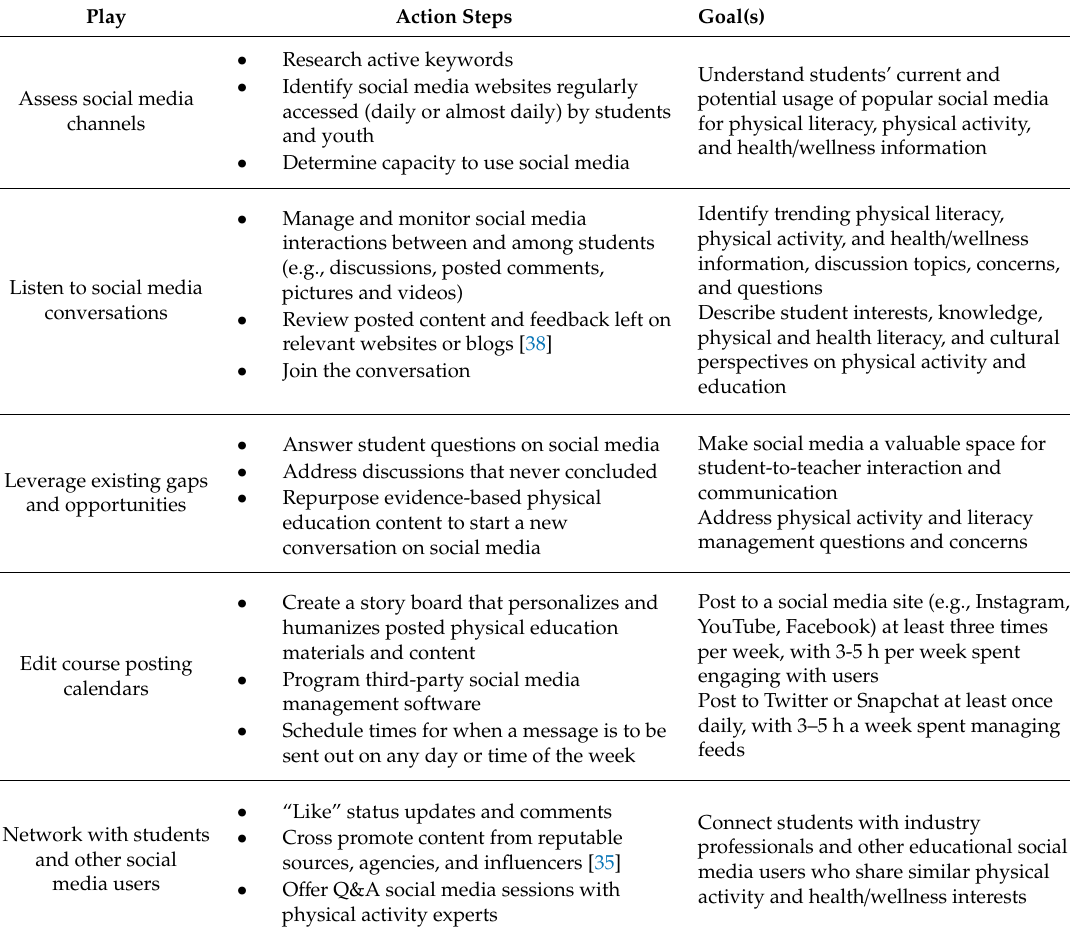
Table 1. Goal-Directed Plays and Action Steps in the ALL-ENGAGE Social Media Playbook. Action